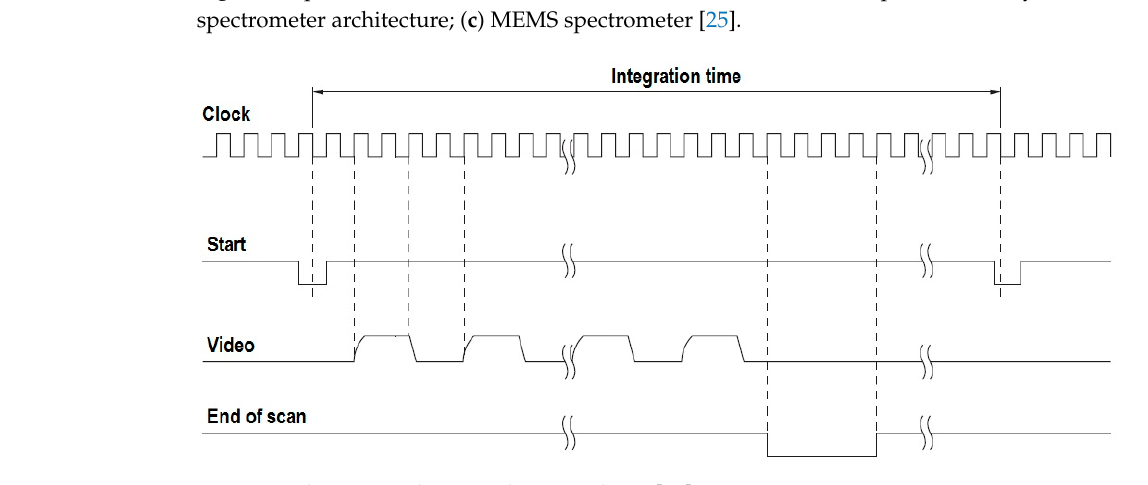
Figure 1. Spectrometer architectures have evolved: ( a ) a traditional spectrometric system; ( b ) mini-spectrometer architecture; ( c ) MEMS spectrometer [25].